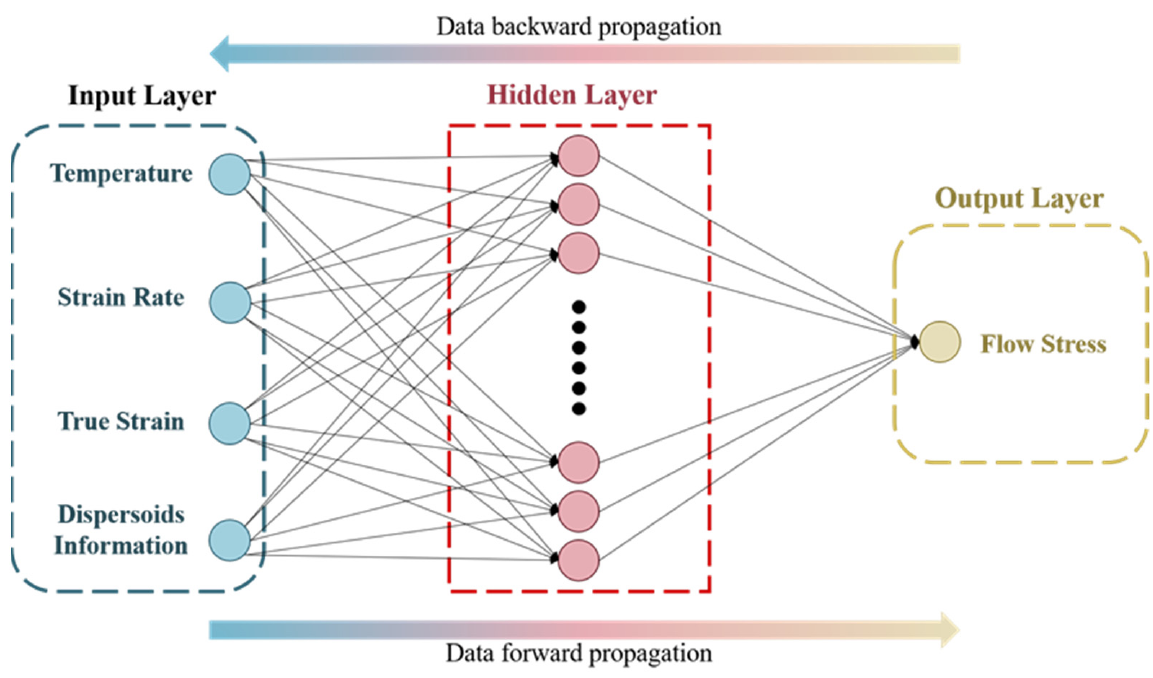
Figure 11. ANN structure employed in this study as well as input and output variables.